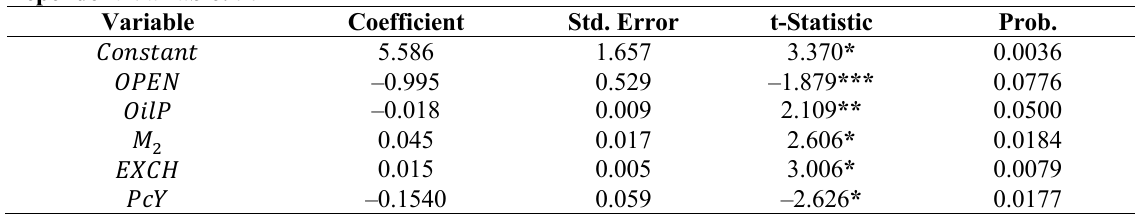
Table 3: Long-Run